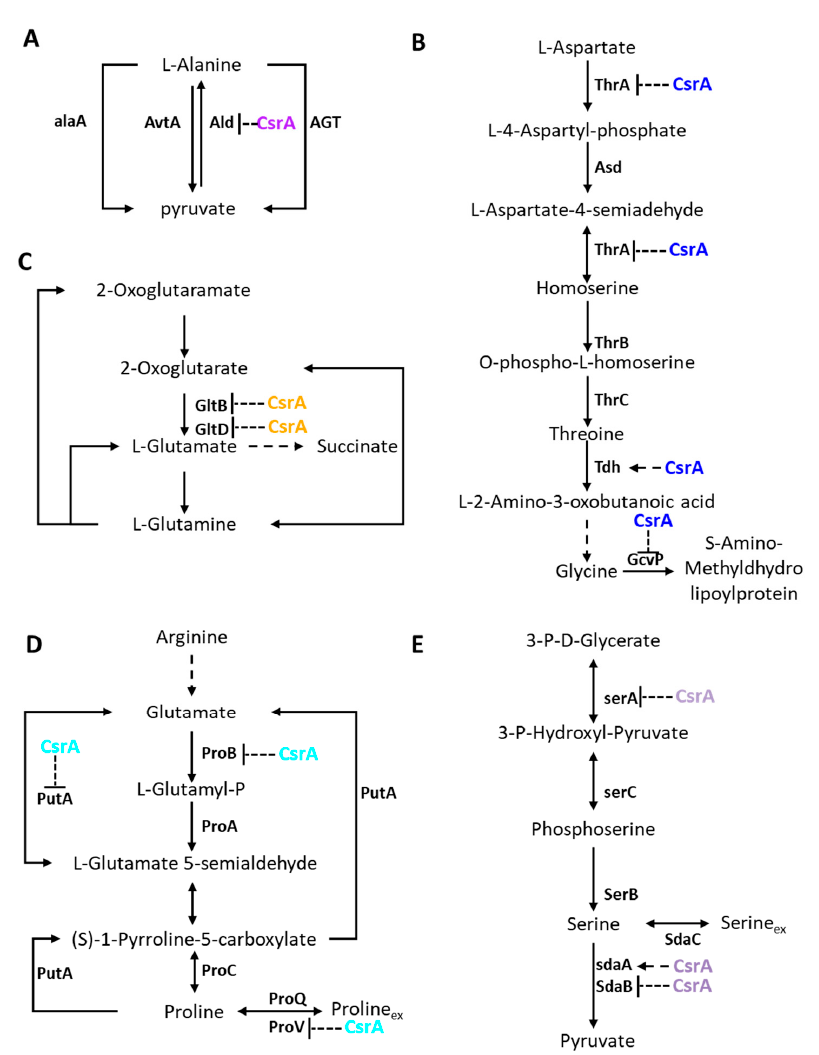
Figure 7. Schematic of metabolic reactions and relevant enzymes involved in amino acid metabolism. Effects of the RNA-binding protein CsrA on the synthesis of enzymes involved in alanine ( A ), glutamine ( B ), threonine ( C ), proline ( D ), and serine ( E ) biosynthesis and utilization. Purple, blue, orange, cyan, and dark goldenrod represent alanine, glutamine, threonine, proline, and serine biosynthesis and utilization respectively. Ald, alanine dehydrogenase; AlaA, alanine- synthesizing transaminase; AvtA, valine–pyruvate transaminase; AGT, pyruvate transaminase; GltD, glutamate synthase, GltB, glutamate synthase. ThrA, bifunctional aspartate kinase/homoserine dehydrogenase I; Asd, aspartate-semialdehyde dehydrogenase; ThrB, homoserine kinase; ThrC, threonine synthase; Tdh, L-threonine 3-dehydrogenase; GcvP, glycine dehydrogenase; ProV, ABC superfamily (glycine/betaine/proline transport protein); ProQ, RNA chaperone; ProB, gamma- glutamyl kinase; PutA, bifunctional proline dehydrogenase/L-glutamate gamma-semialdehyde dehydrogenase; ProA, glutamate-5-semialdehyde dehydrogenase; ProC, pyrroline-5-carboxylate reductase; SdaC, serine transporter; SdaA, L- serine dehydratase 1; SdaB, L-serine ammonia-lyase; SerA, D-3-phosphoglycerate dehydrogenase; SerB, phosphoserine phosphatase; SerC, phosphoserine